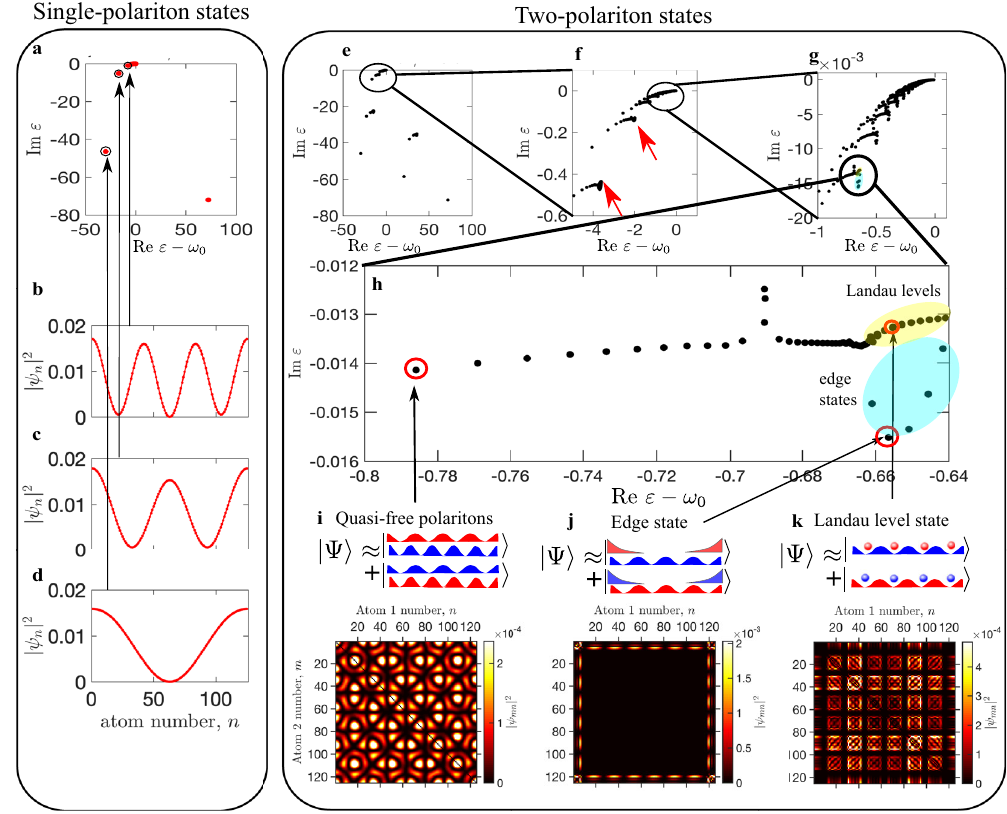
Fig. 2 Single- and two-polariton energy spectra. a complex energy spectrum of single-polariton modes. Three characteristic eigenstates are shown in panels b – d . e – h Two-polariton energy spectrum zoomed in different scales. i , j , k Spatial color maps of different characteristic two- polariton eigenstates ∣ ψ nm ∣ 2 . Calculation has been performed for N = 125 atoms and ω 0 d / c = 0.02. Energy is measured in units of Γ 0